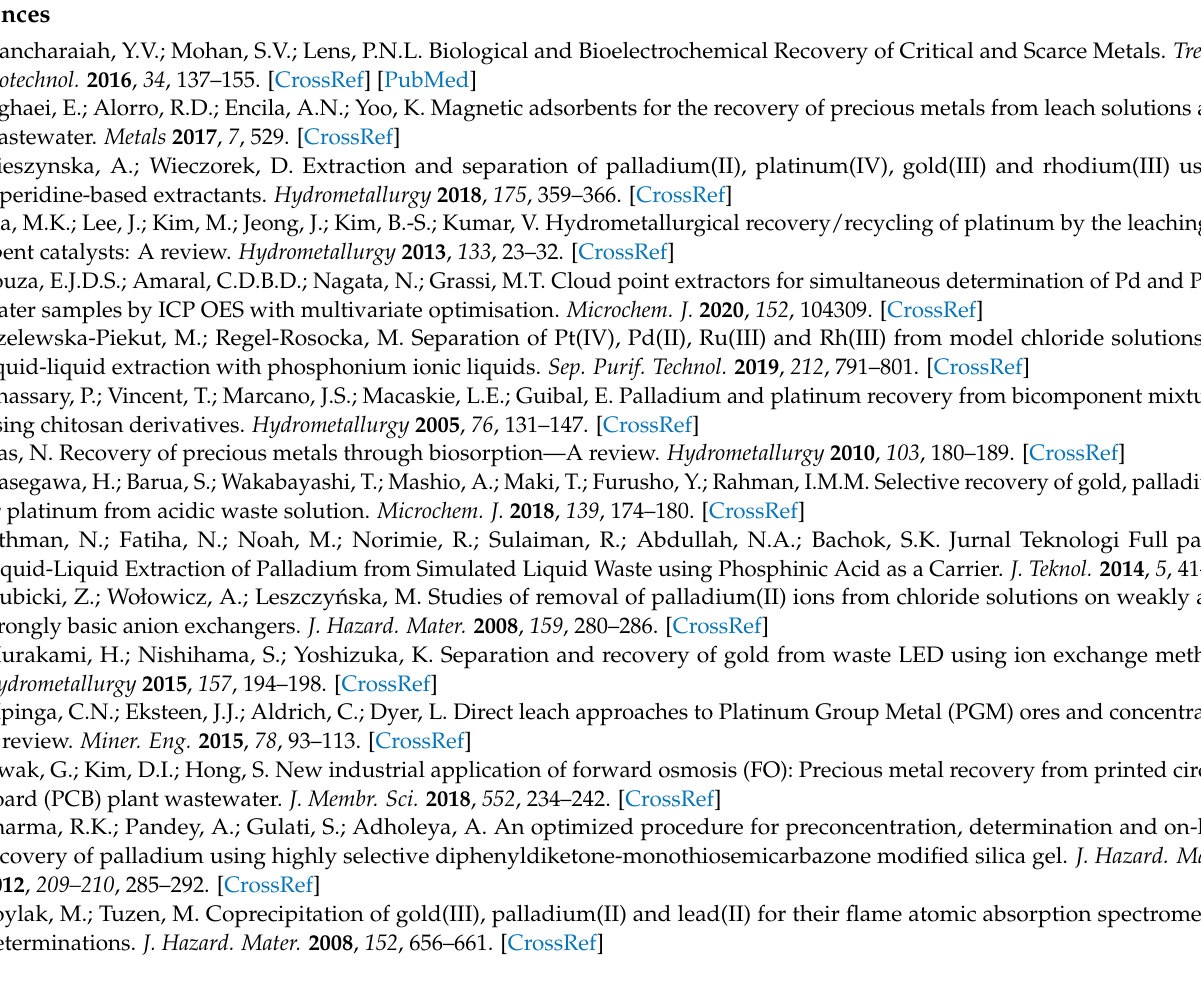
Figure S3: Freundlich isotherm model plots for adsorption of Au and Pd onto Zn–Al–LDH@ZIF– 8 nanocomposite; Table S1: Central composite design matrix and %recoveries efficiency as an analytical